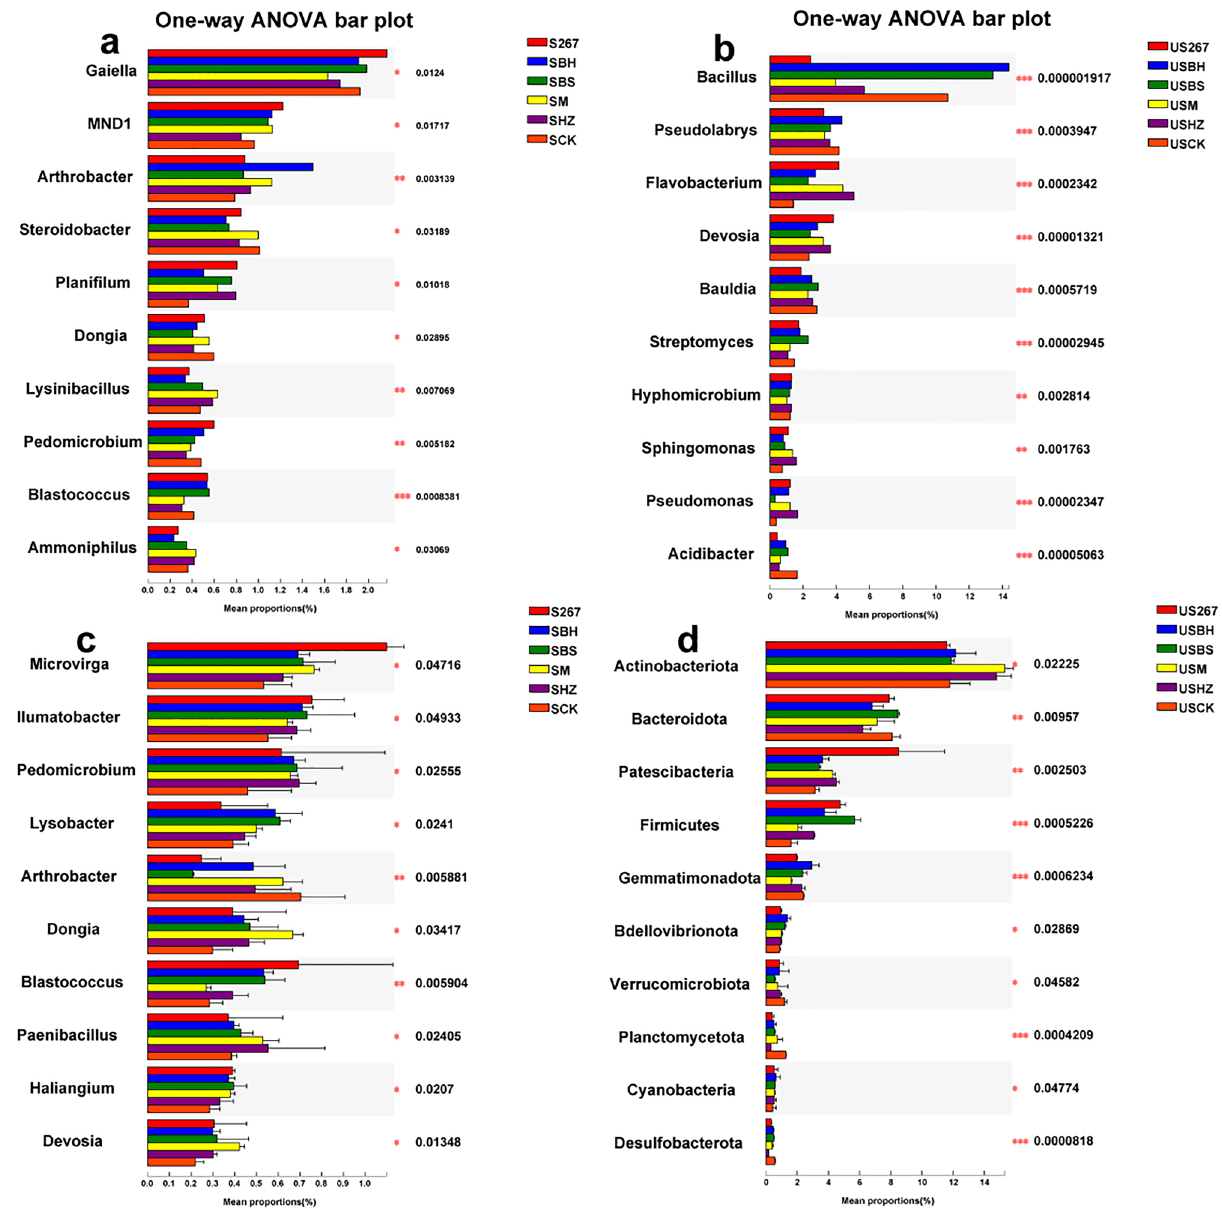
Figure 3. Relative abundance of bacterial genera detected in soil ( a early samples; c late samples) and substrate ( b early samples; d late samples) after different biofertilizer treatments. The number of asterisks indicates significant differences between treatments according to a one-way ANOVA and FDR (False Discovery Rate) adjustment (*0.01 < P ≤ 0.05; **0.001 < P ≤ 0.01; ***P ≤ 0.001). S267 = Trichoderma Strain 2 67 added to soil; SBH = Bacillus subtilis and T. harzianum biofertilizers added to soil; SBS = B. subtilis biofertilizer added to the soil; SM = Compound biofertilizer added to soil; SHZ = T. harzianum biofertilizer added to soil; SCK = Untreated soil. US267 = T. 267 biofertilizer added to substrate; USBH = B. subtilis and T. harzianum biofertilizers added to substrate; USBS = B. subtilis biofertilizer added to substrate; USM = Compound biofertilizer added to substrate; USHZ = T. harzianum biofertilizer added to substrate; USCK = Untreated